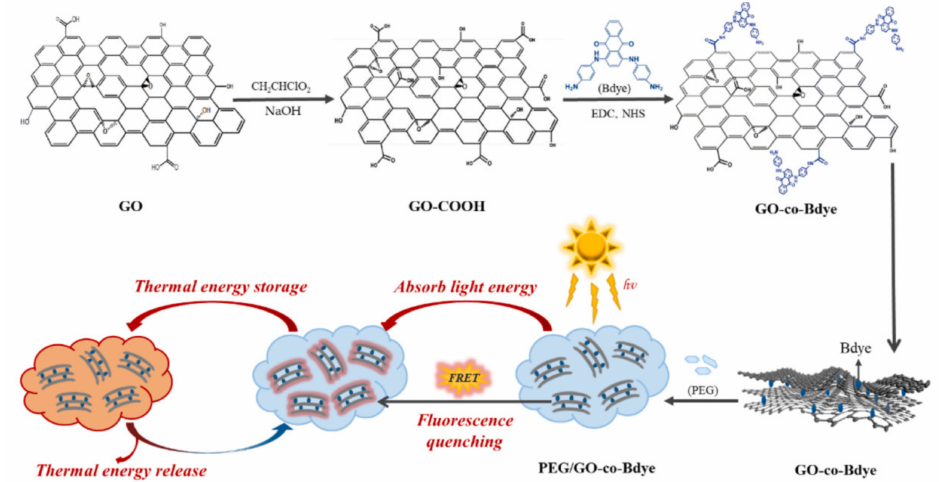
Figure 12. Schematic illustration of the preparation processes of PEG/GO-co-Bdye composite PCMs (Reproduced with permission from ref. [63]. Copyright 2022 Elsevier